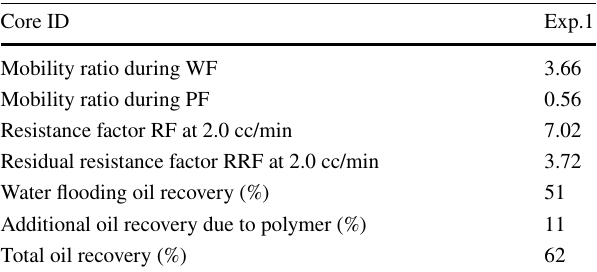
Table 4 Summary of major results from first core flooding experi-